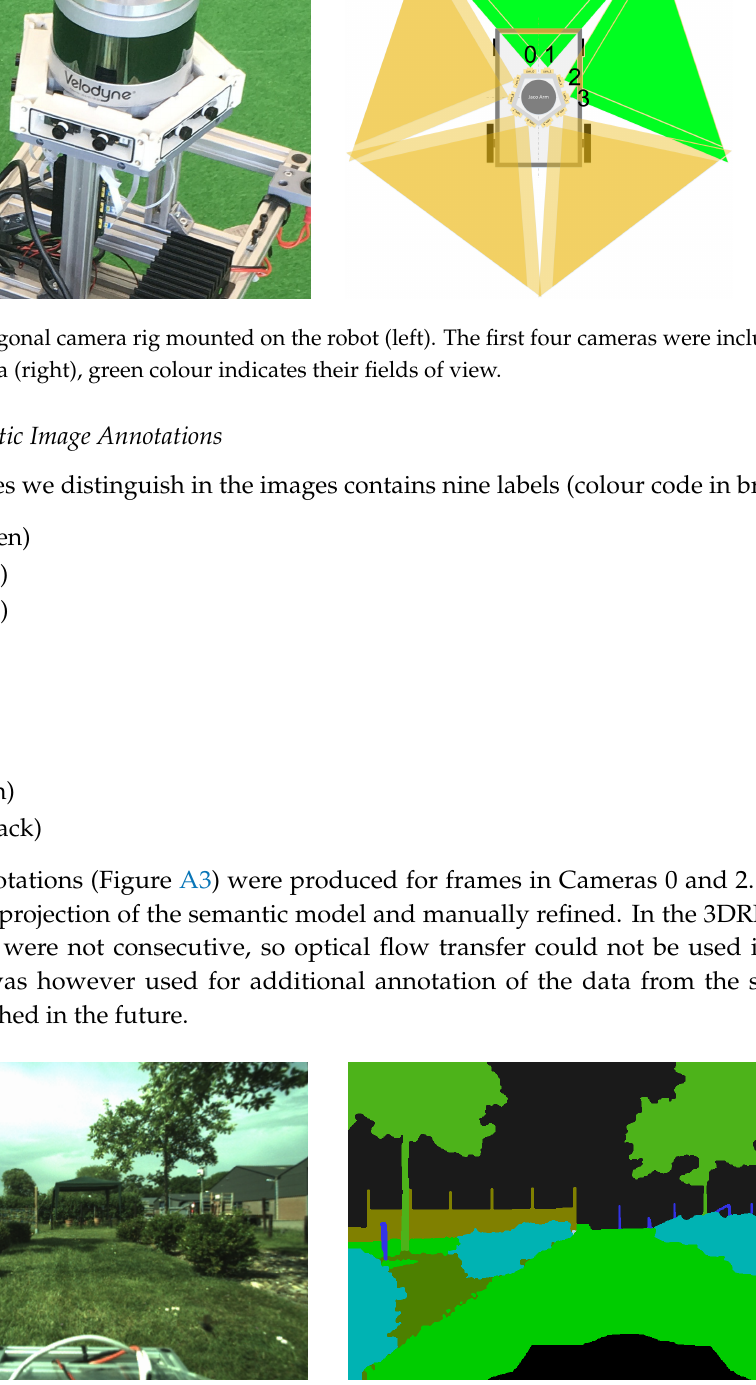
Figure A3. Undistorted image from Camera 0 (left) and its semantic annotation